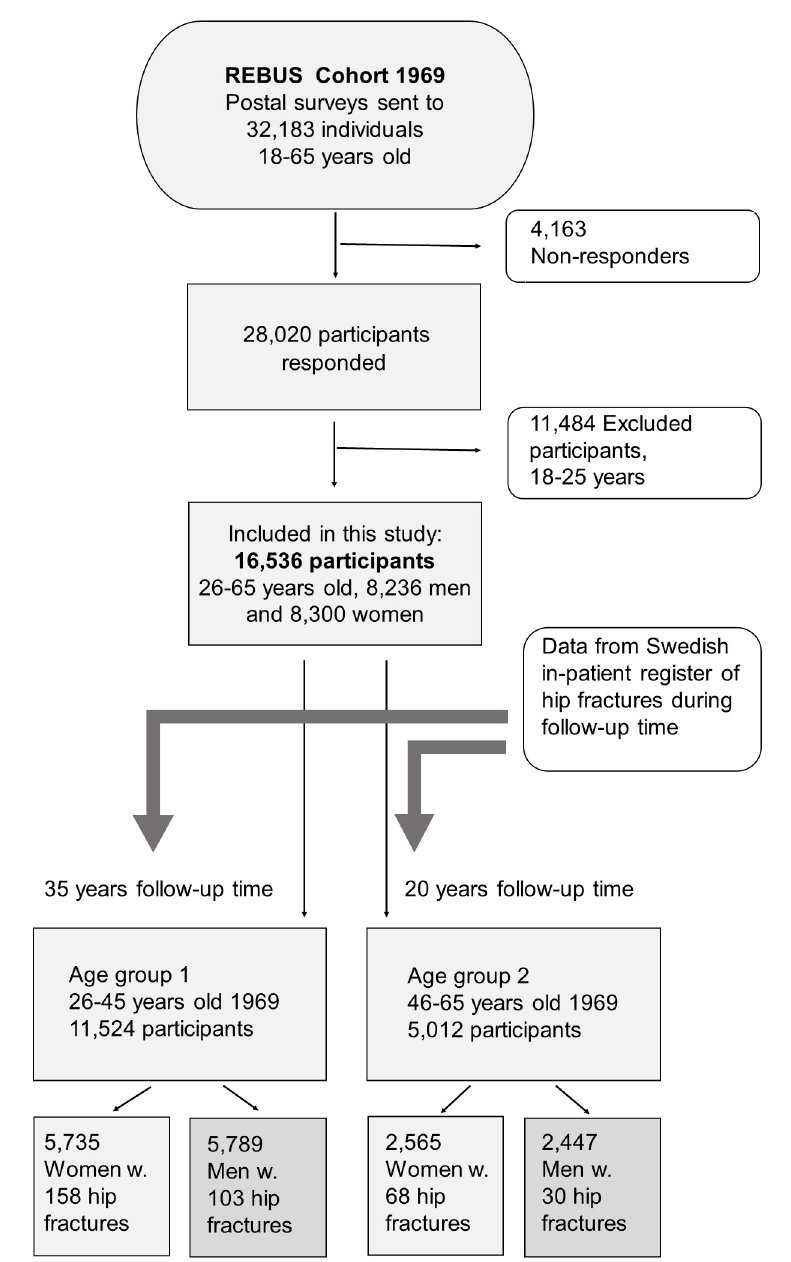
Fig 1. Flow chart of the study population in the present